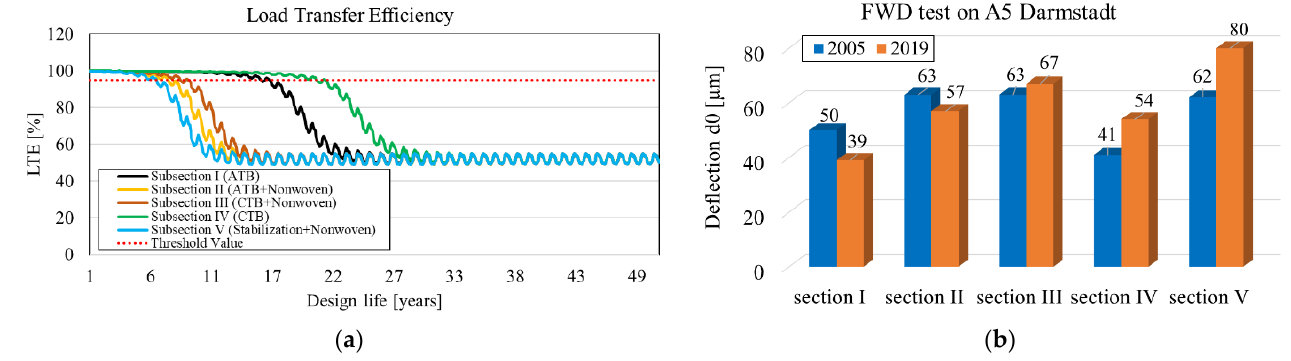
Figure 12. Different findings from design method and on-site measurements for A5 near Darmstadt: ( a ) variation of LTE prediction over time from the MEPDG; ( b ) investigation of bearing capacity (FWD) from 2005 to 2019.